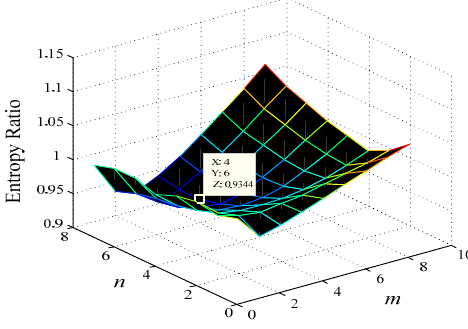
Figure 5. The IGBT experimental data (IGBT4) entropy ratio diagram.